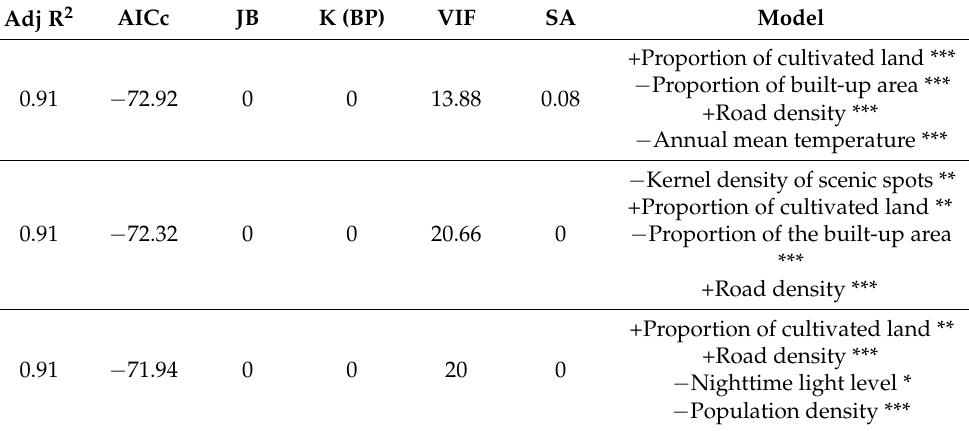
Table A1. The highest adjusted R 2 results of the explanatory regression analysis of the PD and four independent